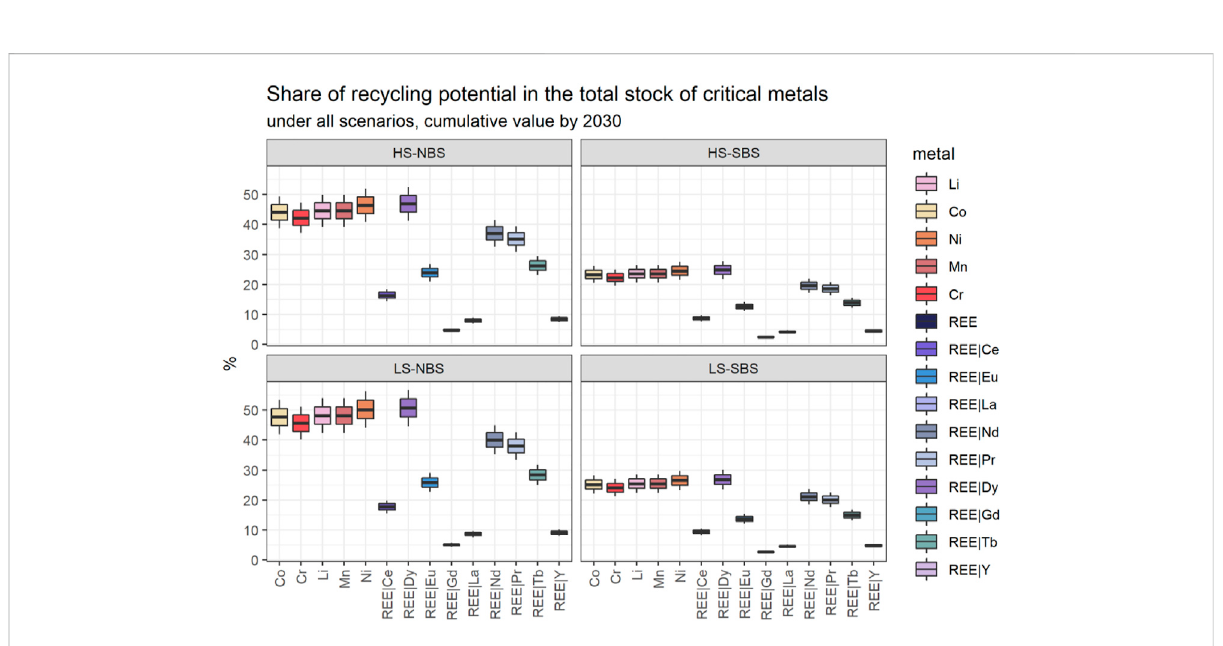
FIGURE 8 ShareofrecyclingpotentialinthetotalstockofcriticalmetalsinChina.Cumulativerecyclingofcriticalmetalsisthesumoftheoreticalrecycling of critical metals of all EOL EVs from 2022 to 2030, and stock is critical metals of EVs in